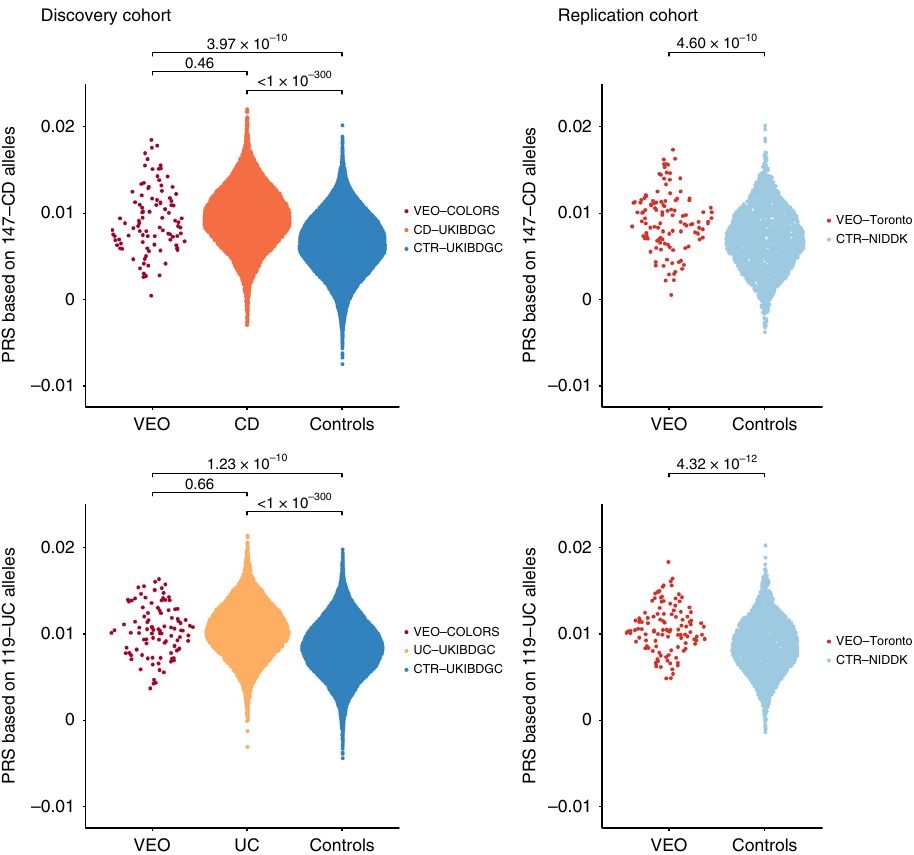
Fig. 3 Distribution of CD and UC risk scores in VEO-IBD, CD, UC cases and healthy controls. The CD score was calculated using 147 CD risk alleles and the UC score using 119 UC risk alleles. Both scores were generated for a discovery cohort comprising 99 VEO-IBD cases (VEO-COLORS), 7578 CD cases, 6318 UC cases, 18,780 UK population controls (from the UKIBDGC), all of European ancestry. The replication cohort comprised 117 VEO-IBD cases (VEO Toronto) and 2603 population controls (from the NIDDK Genetics Consortium). The CD and UC risk scores did not signi fi cantly differ between the two VEO-IBD cohorts (CD P = 0.98; UC P = 0.64). The Student ’ s t -test was used in group